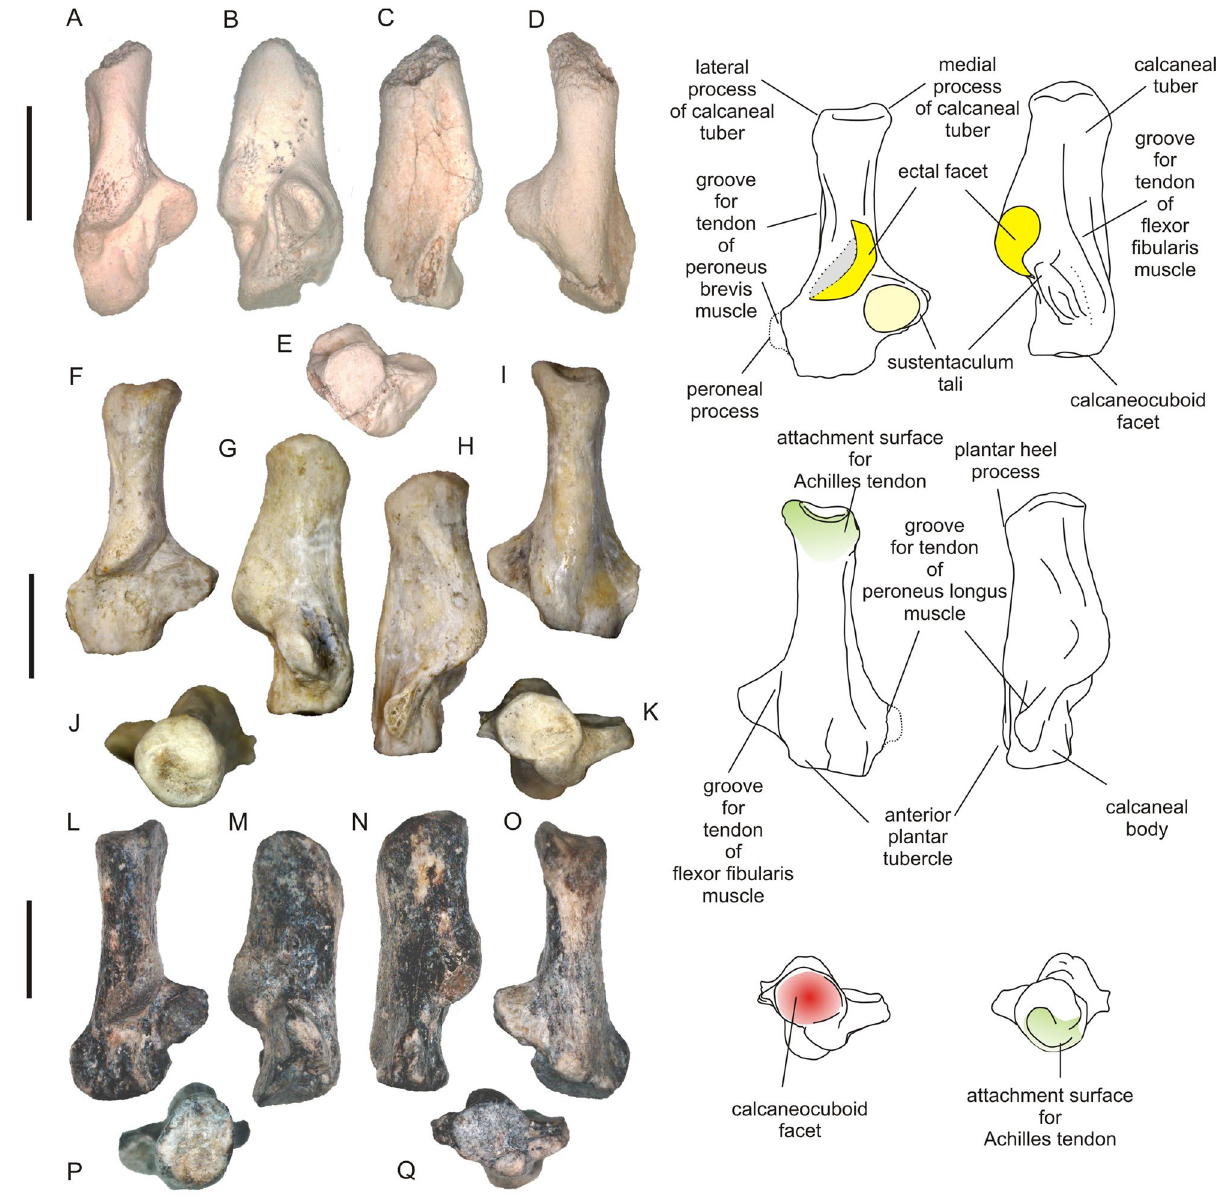
Figure 3. Ischyromyid calcanei from the early middle Eocene of the Erlian Basin, Nei Mongol, China. ( A – E ), Asiomys dawsoni (IVPP V24417), right calcaneus, juvenile?; ( F – K ), species A (IVPP V24416), right calcaneus, adult; ( L – Q ), species B (IVPP V24418), right calcaneus, adult. In: A, F and L, dorsal; B, G and M, medial; C, H and N, lateral; D, I and O plantar; J and P caudal; E, K and Q, cranial views. Explanatory line drawings (right side) show important morphological features. Note sustentacular facet marked pale yellow. Scale bar equals 10 mm. (Photographs taken by Łucja Fostowicz-Frelik; drawings created in Corel Draw X4 (v.14.0.0.567) by Łucja